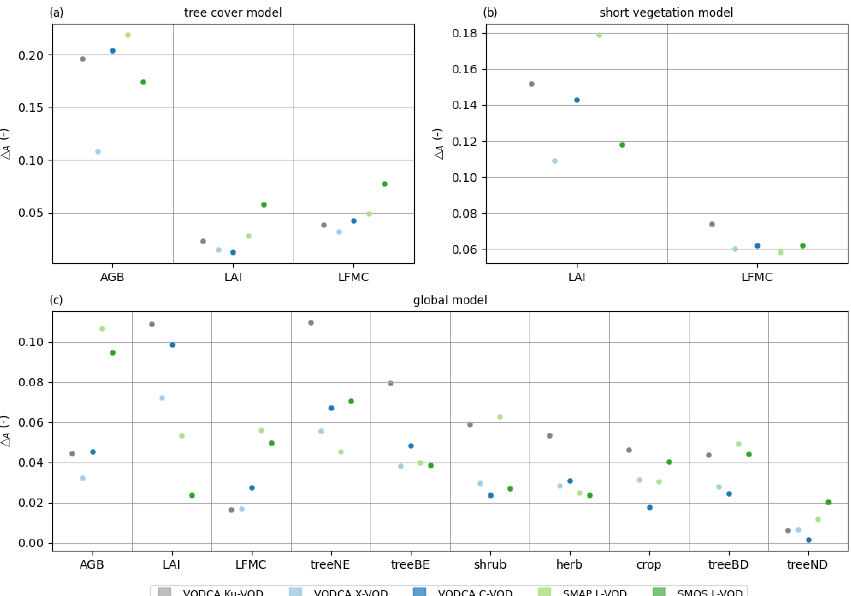
Figure 7. Amplitude ( (cid:49) A ) of RF ALEs for monthly models. The order of the x axis is solely sorted by the importance of the features while trying to ensure comparability of land-cover-specific models (a, b) and global models (c) , using PFT fractions as additional predictors. Similar results are achieved for other land-cover-specific models, e.g. treeB, treeN, herb, or crop models, as well as for 8-daily based models but with a slightly smaller (cid:49) A